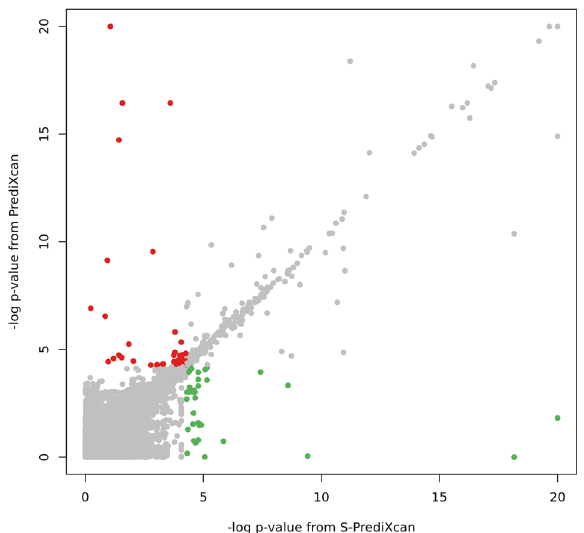
Fig. 3 Scatter plot of log-transformed p -values from SNP-based (PrediXcan) and summary statistic (S-PrediXcan) GReX approach. Each dot shows the gene-level p -value from a SNP-based approach (PrediXcan, y-axis) and summary statistic approach (S-PrediXcan, x-axis). Color indicates that the signal (tissue-speci fi c GReX) was only identi fi ed in PrediXcan (red, FDR < 0.05) or only in S-PrediXcan (green, FDR <